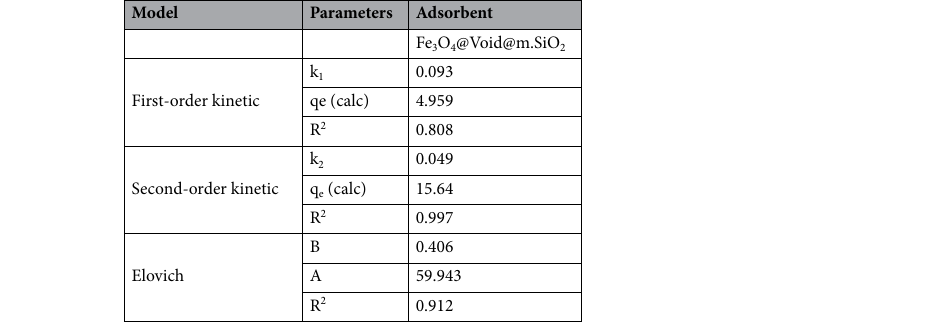
Table 1. Kinetic parameters for MB adsorption using Fe 3 O 4 @Void@m.SiO 2 .